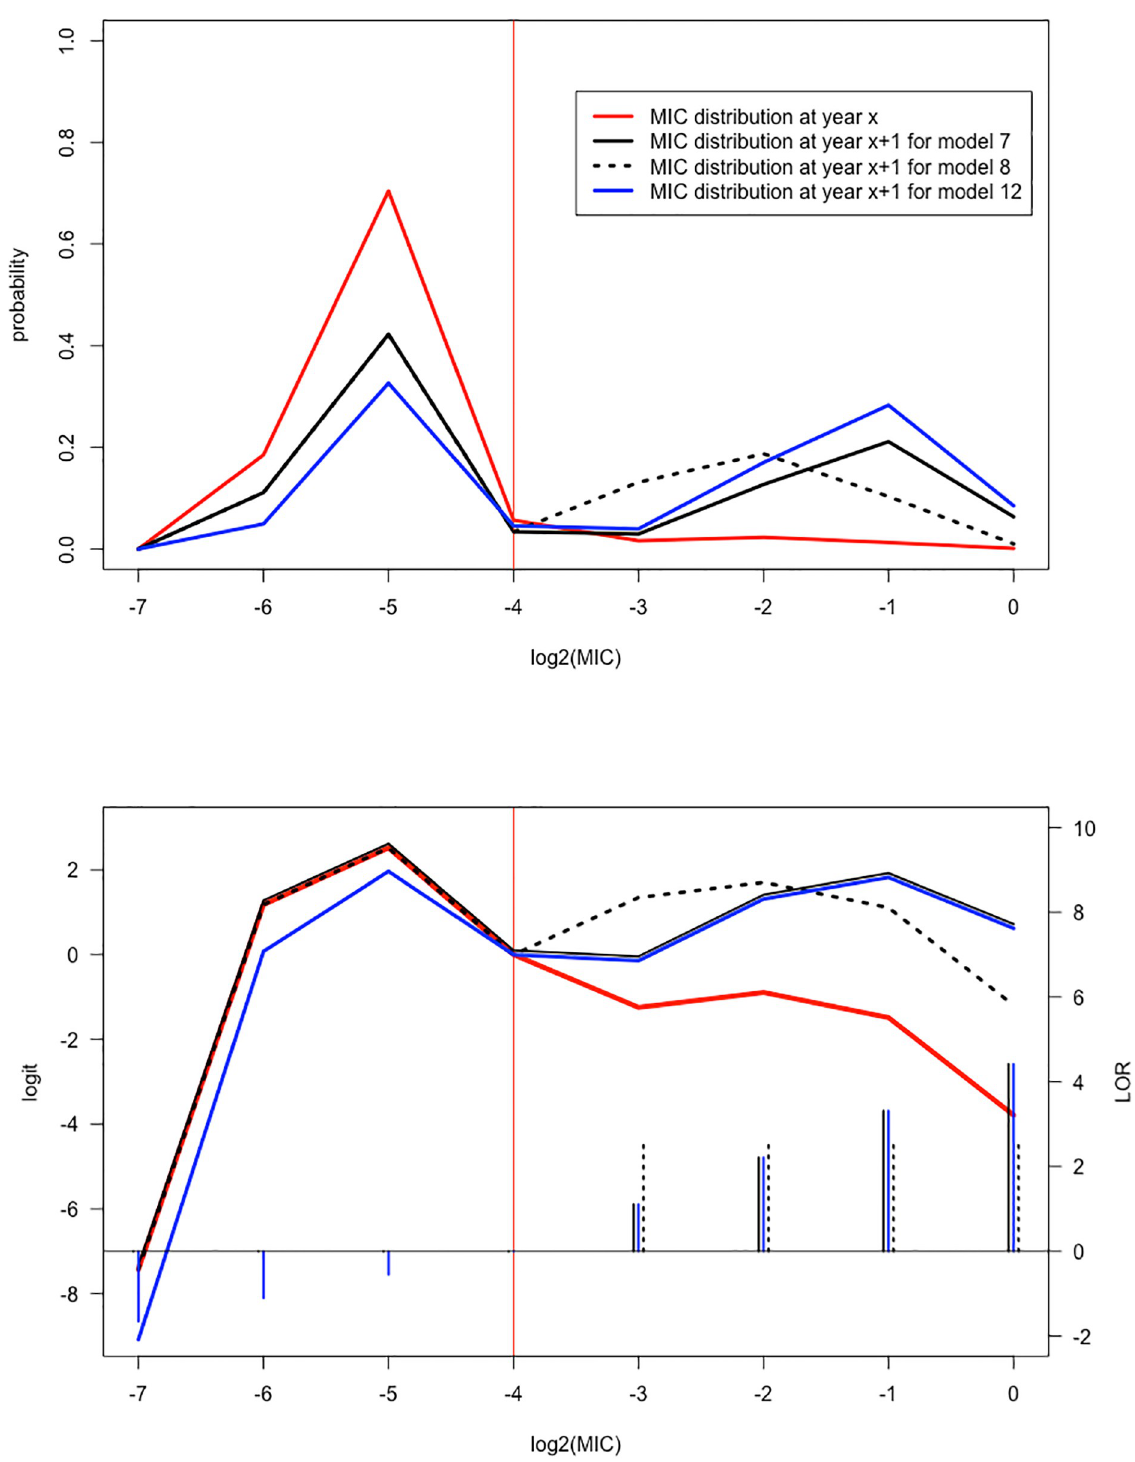
Fig 1. The family of models. Illustration of particular models using the identity, sign and null function, with reference to the setting of the CIPR data analysis (Table 2). The red curve refers to the MIC distribution at year x , the other curves refer to the distribution at year x + 1, according to different models: model 7 (solid, black) is the model with f with f s ( x ) = 0 and f r ( x ) = sign( x ) with β r > 0; model 12 (solid, blue) is the model with f s ( x ) = x with β s > 0, and f r ( x ) = x with β r > 0. The vertical red line refers to the ECOFF category. The upper panel shows the MIC distribution P ( y = j ), j = − 7, ... , 0 (corresponding to MIC